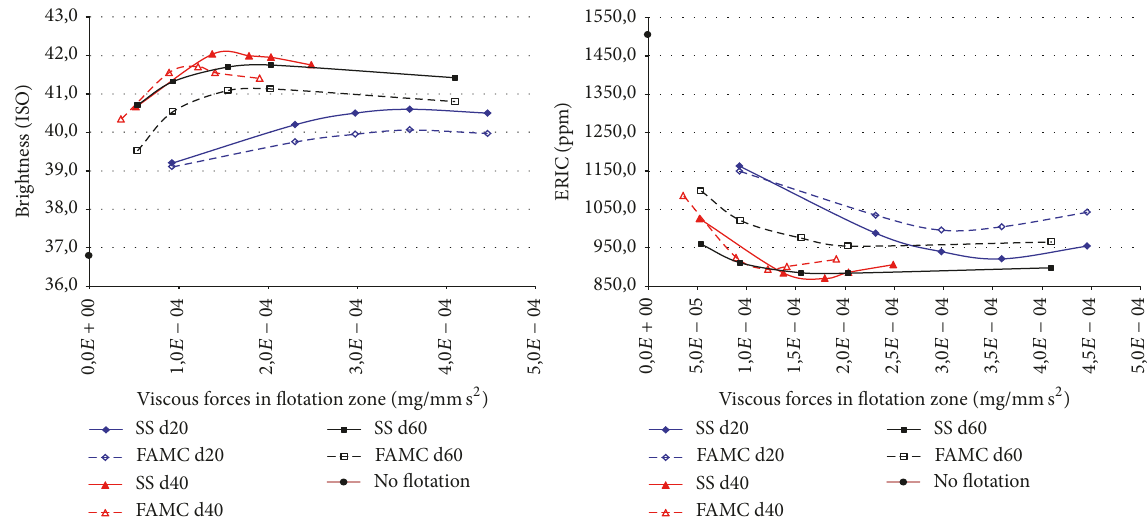
Figure 7: Effect of viscous force in the flotation zone on the resulting brightness and ERIC of the deinked pulp.